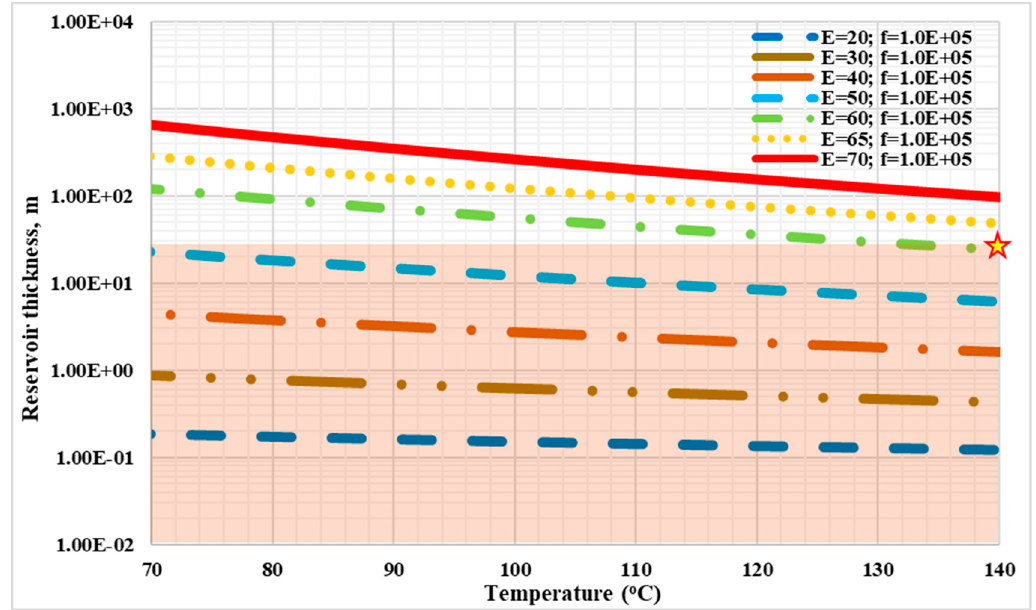
ff ect of the critical activation energy of crude oil on spontaneous Figure 6. The effect of the critical activation energy of crude oil on spontaneous ignition. Figure 6. The e